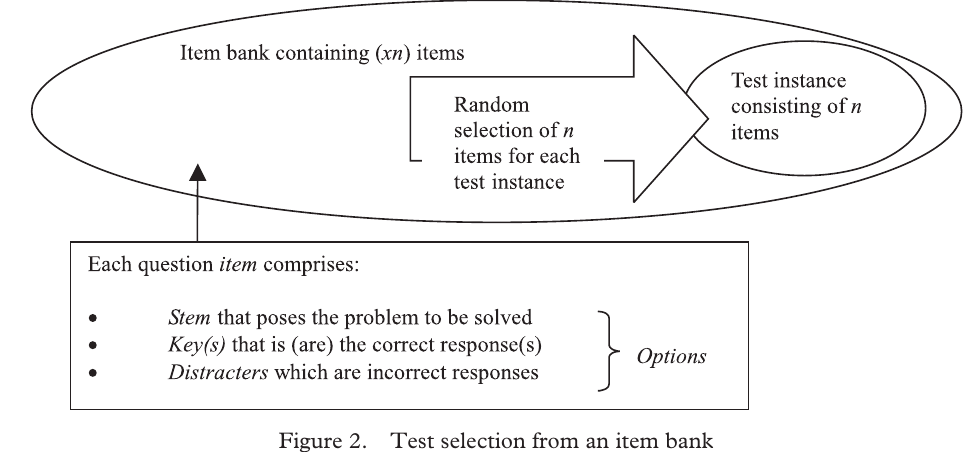
Figure 2. Test selection from an item